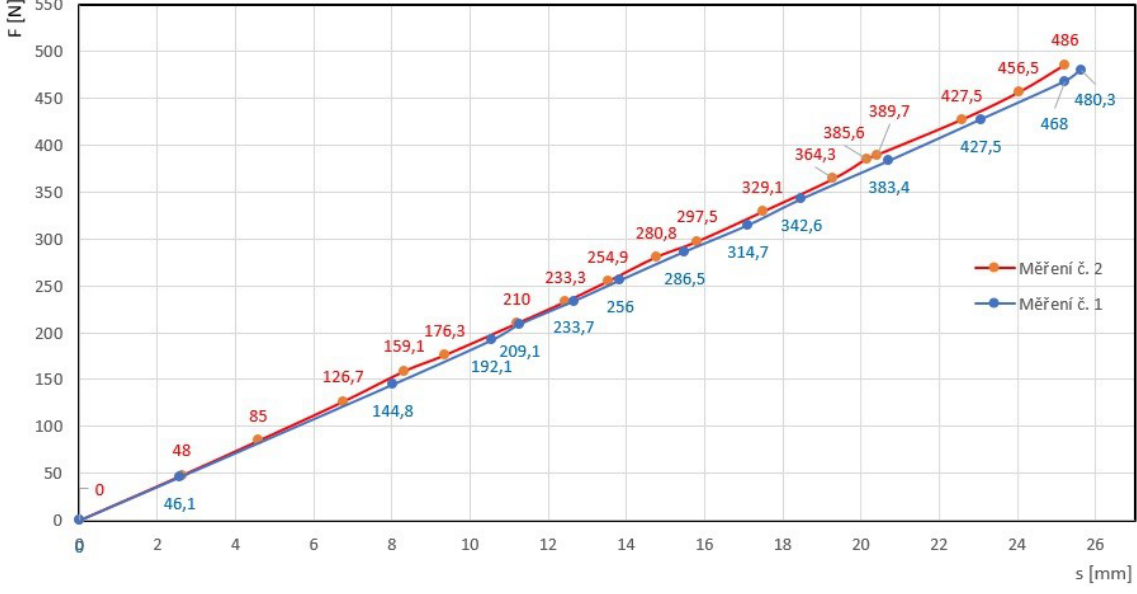
Figure 8: Spring compression vs. compressive force